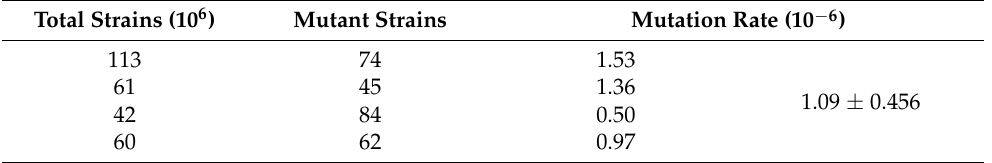
Table 6. Spontaneous mutation rate of rpsL in the RCA reaction.